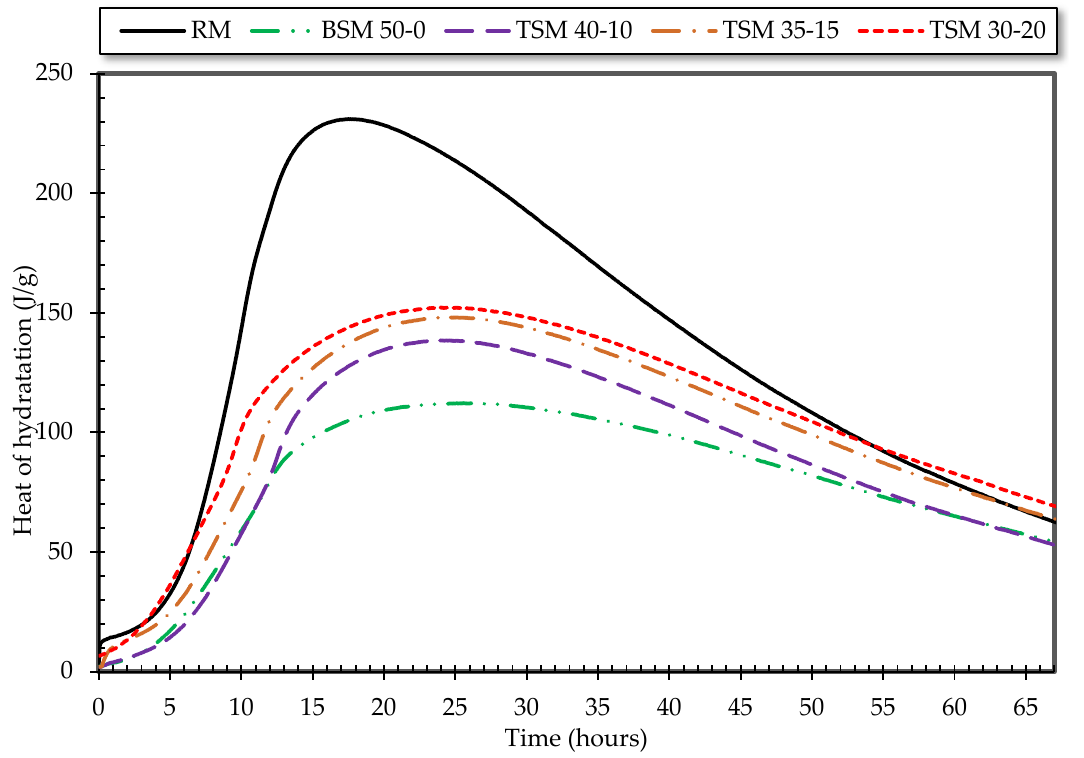
Figure 4. Heat hydration versus time as determined by semi-adiabatic Langavant calorimetry.